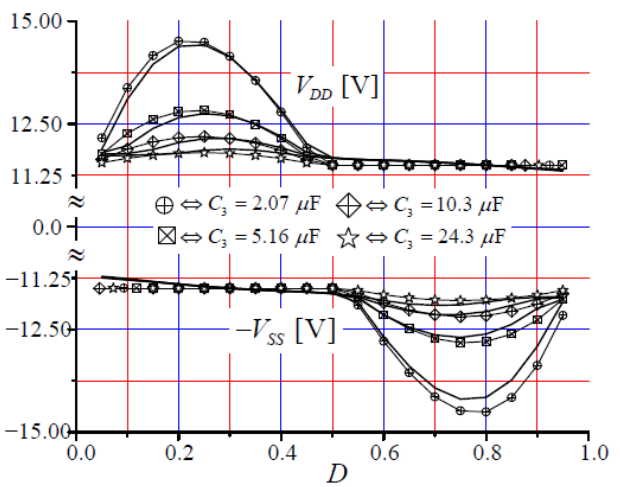
Figure 8. Measured and calculated supply voltages V DD and V SS for the selected set of C 3 values. Measured voltages are presented as line charts, whereas calculated voltages are presented as symbol + line charts.